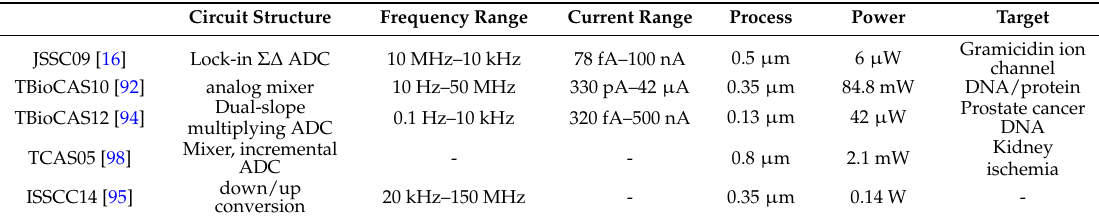
Table 2. Performance summary of impedimetric readout circuitry.